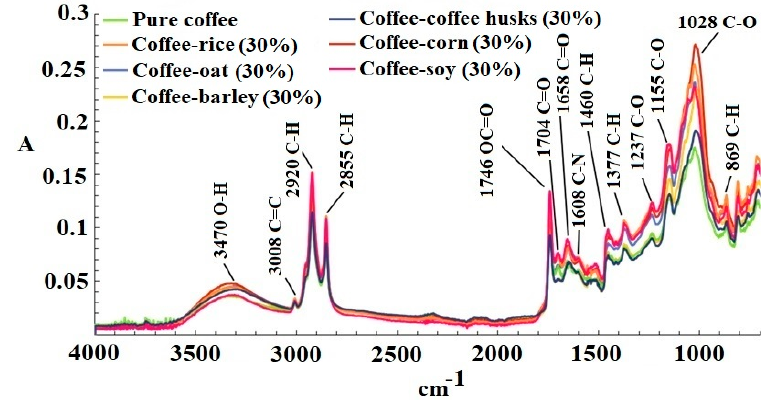
Figure 1. Infrared Fourier transformed spectrophotometer (FT-MIR) spectra of pure coffee adulterated with each adulterant with a concentration of 30%.